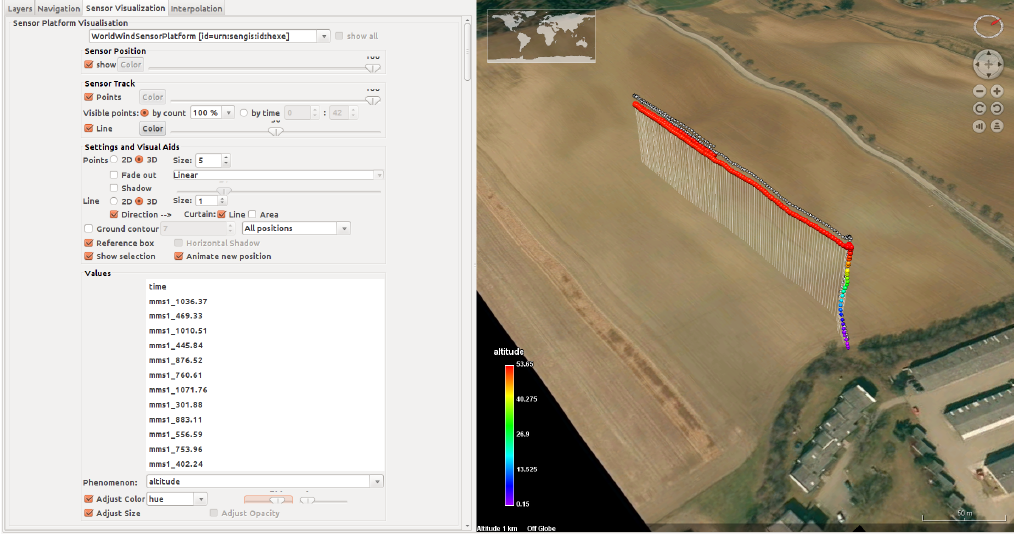
Figure 6. Example of the SPF “SensorVis” output plugin [32] live-visualization of Hexe, a UAS sensor system, operating during the field trial. On the left side, visualization parameters can be selected and configured, depending on the available sensor observations. On the right side, the flight path and the selected sensor observation values are visualized by colored spheres, i.e. , indicating the received flight altitude